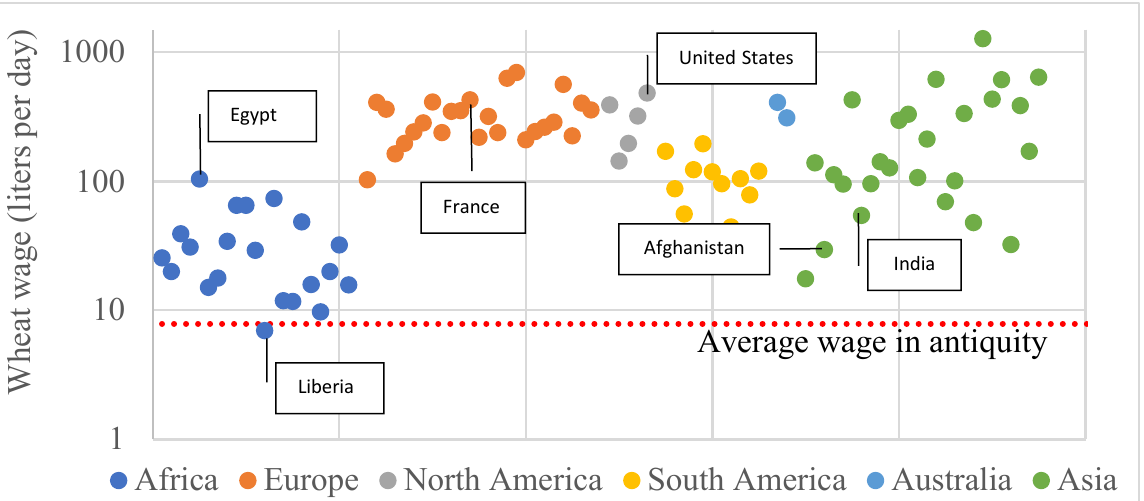
Figure 8. ( a ) Values of gold, silver, oil and wheat, ( b ) Gold to wheat ratio, silver to wheat ratio, oil to wheat ratio [29,30,46].